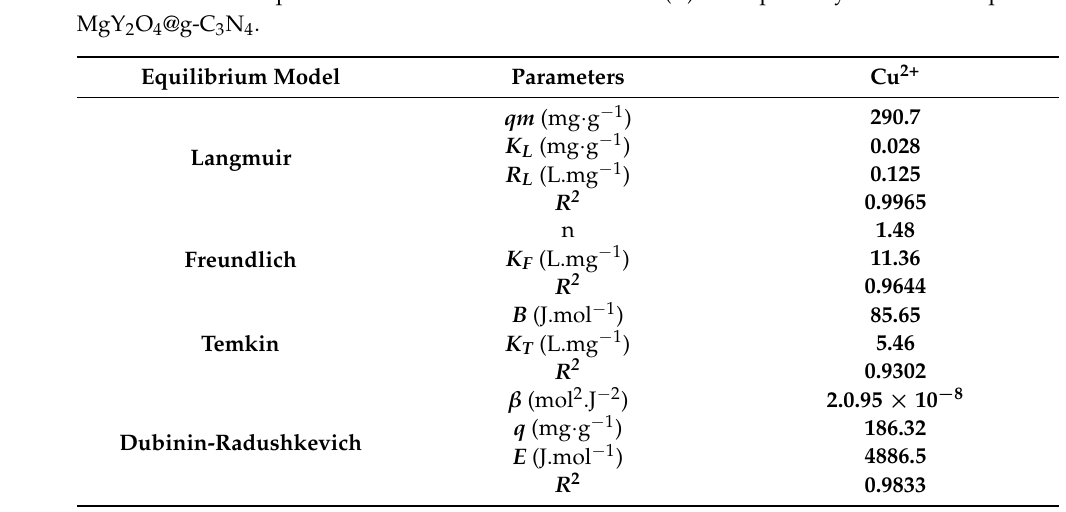
Figure 6. Removal of Cu (II) ions equilibrium data form fi tt ing using non-linear: ( a ) Langmuir; ( b ) Freundlich; ( c ) Temkin; and ( d ) Dubinin-Radushkevich models. Table 1. Various equilibrium Isotherm constants for Cu (II) adsorption by the